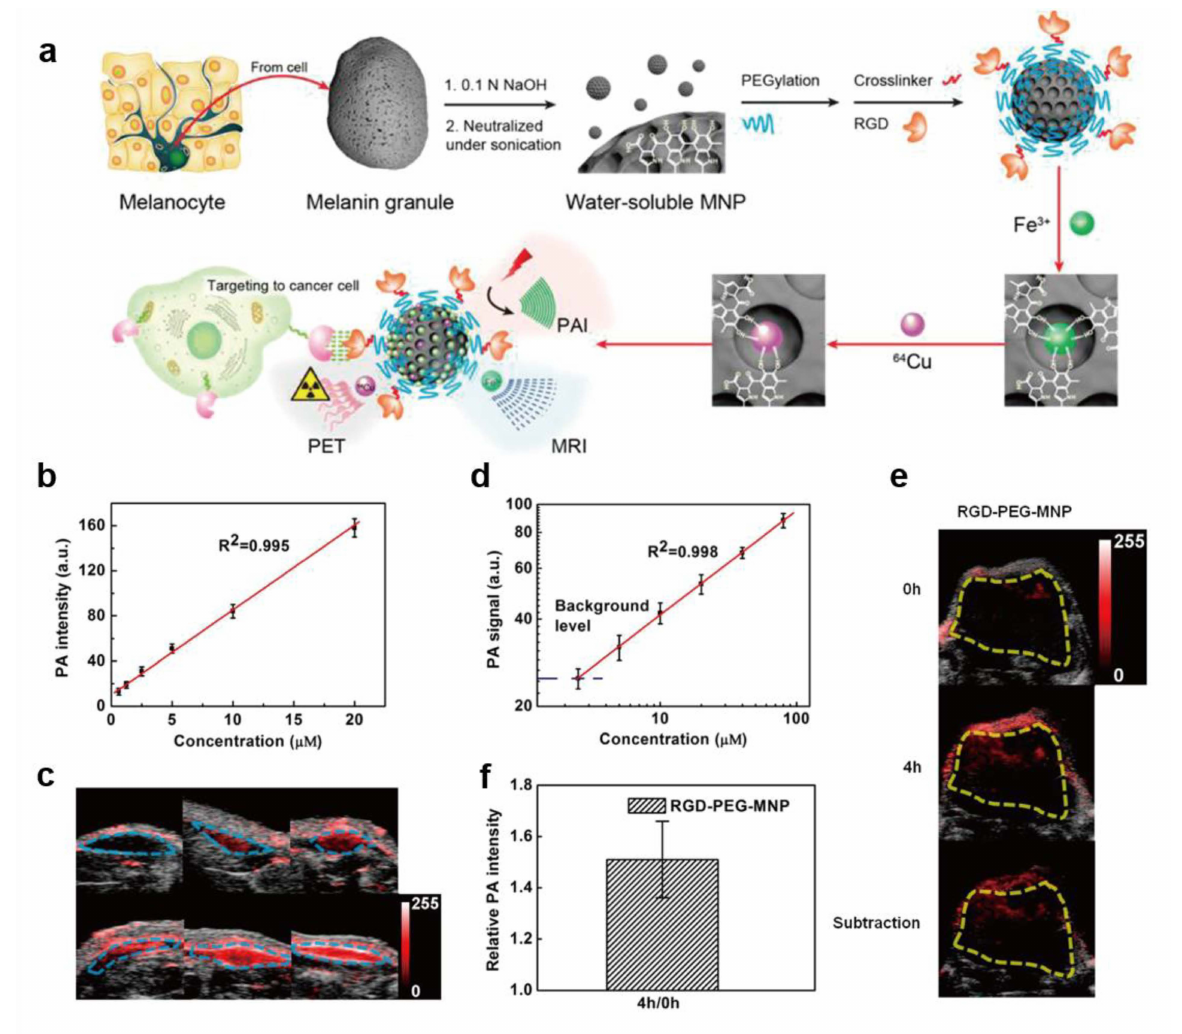
Figure 5. Multimodality molecular imaging of ultrasmall melanin nanoparticles. ( a ) Schematic diagram of synthesis of nanoparticles and multi-model imaging. ( b ) The photoacoustic signal produced by PEG-MNPs at concentrations of 0.625, 1.25, 2.5, 5.0, 10, and 20 µ M, and it was observed to be linearly dependent on its concentration (R 2 = 0.995). ( c ) Photoacoustic detection of PEG-MNP in living mice. ( d ) The photoacoustic signal from each inclusion was calculated. ( e ) The overlaying of ultrasonic (gray) and photoacoustic (red) imaging of U87MG tumor before and after tail-vein injection of RGD-PEG-MNP in living mice. ( f ) Quantitative analysis of enhanced PA signal of U87MG tumor after injection of RGD-PEG-MNP at 4 h